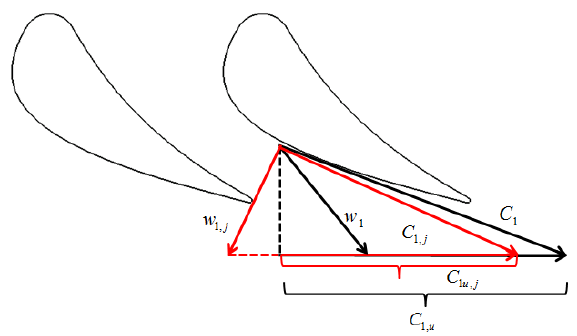
Figure 12. Velocity triangle distribution downstream of cavity exit.